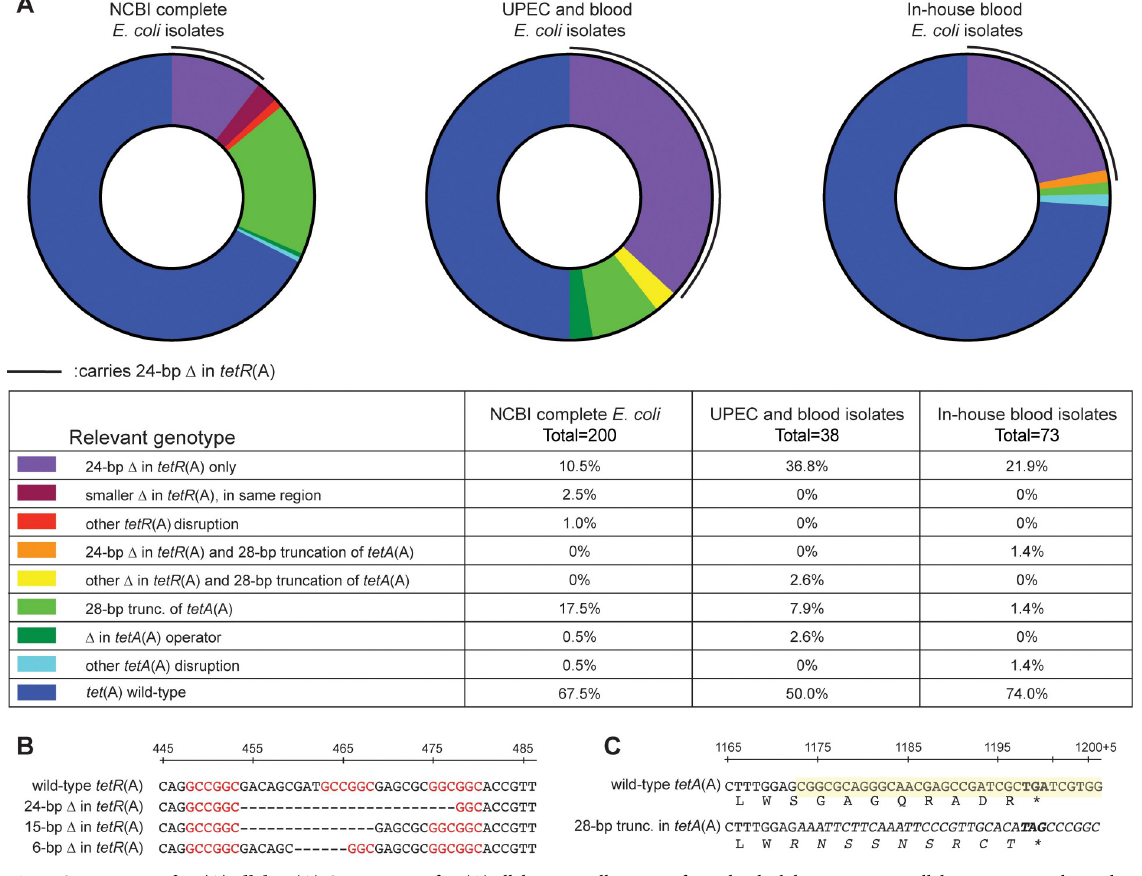
Fig 3. Occurrence of tet (A) alleles. ( A ) Occurrence of tet (A) alleles in 3 collections of E . coli . Black lines represent alleles containing the 24-bp deletion in tetR (A). Legend to the figures and detailed frequencies are given in the table. The underlying data can be found in S1 Data. ( B ) Sequence of the region of tetR (A) prone to deletions, with regions of high similarity marked in red. ( C ) Sequence and translation of the 28-bp truncation of tetA (A). The 28 base pairs at the 3 0 -end of tetA (A) that differ in the tetA (A) variant with the 28-bp deletion are highlighted in yellow in the wild-type sequence and italicised in the variant. The resulting alternative amino acids sequence in the variant TetA(A) is italicised. In-frame stop codons are in bold.